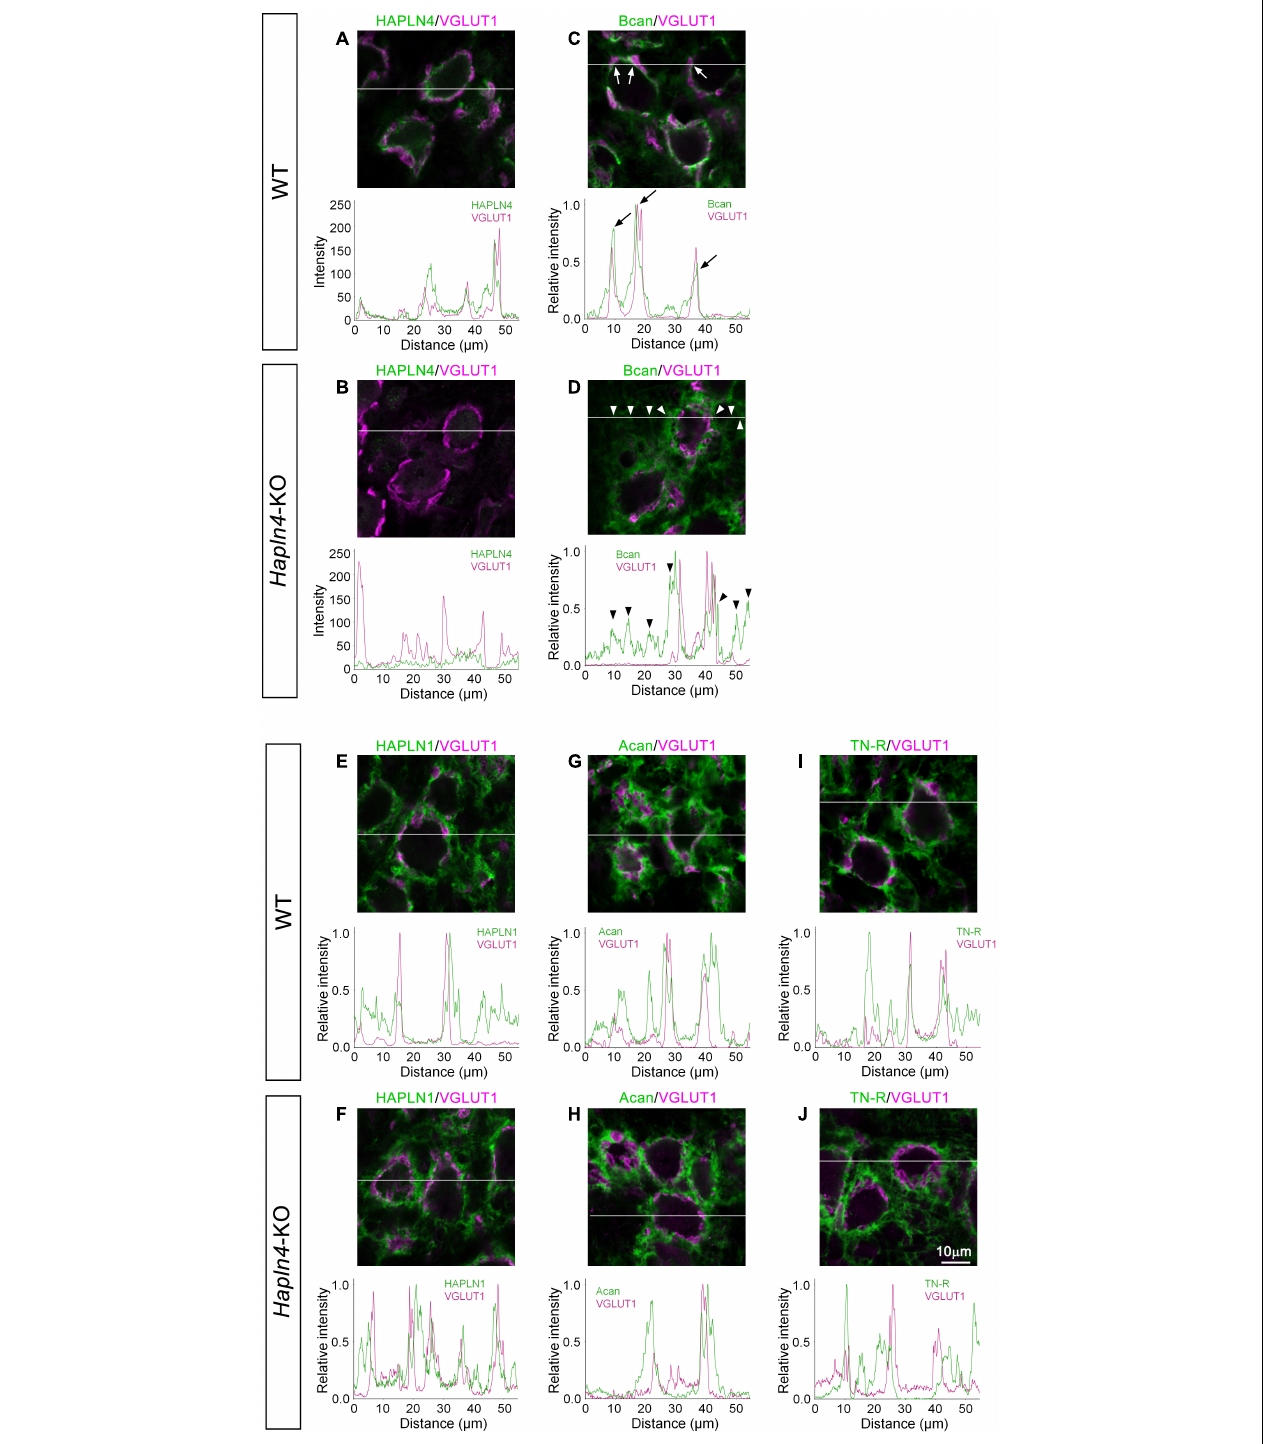
FIGURE 2 | Ectopic expression of brevican in the medial nucleus of the trapezoid body (MNTB) of Hapln4 -KO mice. To clarify the spatial location of perineuronal net components, the immunoreactivity of HAPLNs (A,B,E,F) , brevican or aggrecan (C,D,G,H) , and tenascin-R (I,J) (green) is examined in the MNTB of 4-month-old adult mice using VGLUT1 as a marker of the calyces of Held (magenta). The intensity profiles of the fluorescence signals along the white lines are shown in the lower panels. The fluorescence intensities are normalized by the highest intensities of individual proteins within the lines except in (A,B) . Since these have a relatively low signal-to-noise ratio of the anti-HAPLN4 antibodies, the background is high when the intensities are normalized as previously described. Of note is the observed ectopic shift of brevican immunolocalization from the perisynaptic space in the wild type (arrows) to the surrounding extracellular space in the neuropil in Hapln4 -KO (arrowheads). Acan, aggrecan; Bcan, brevican; TN-R, tenascin-R. The scale bar represents 10 µ m.